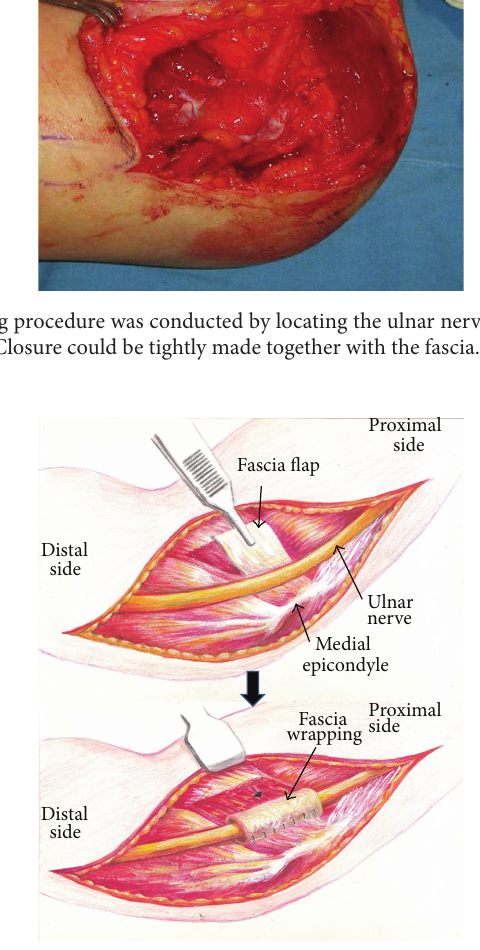
Figure 3: Schematic illustration of the wrapping